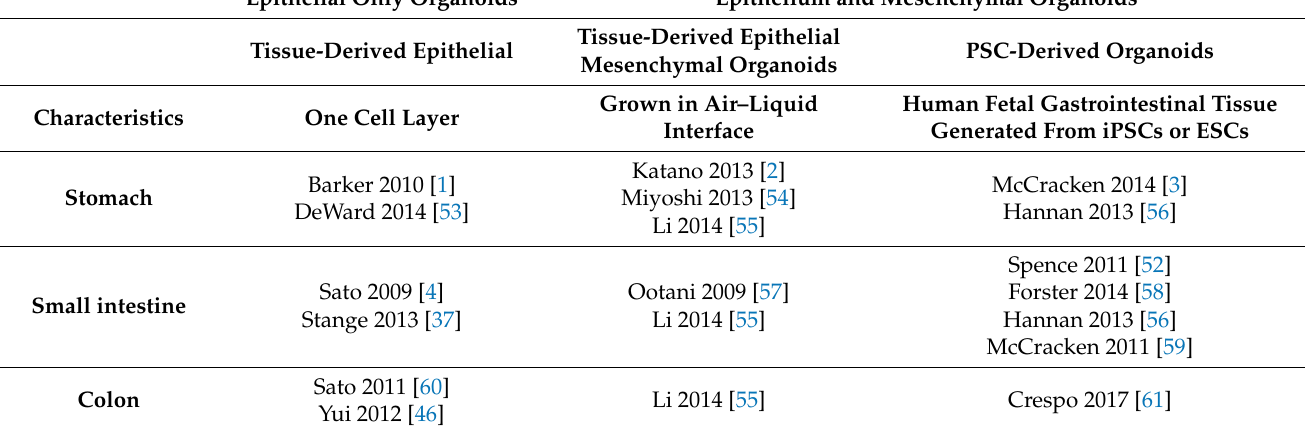
Table 1. Long-term culture of gastrointestinal organoids. Organoids from gastric epithelial cells or epithelial and mesenchymal cells are compared. The characteristics of gastrointestinal organoids are summarized.